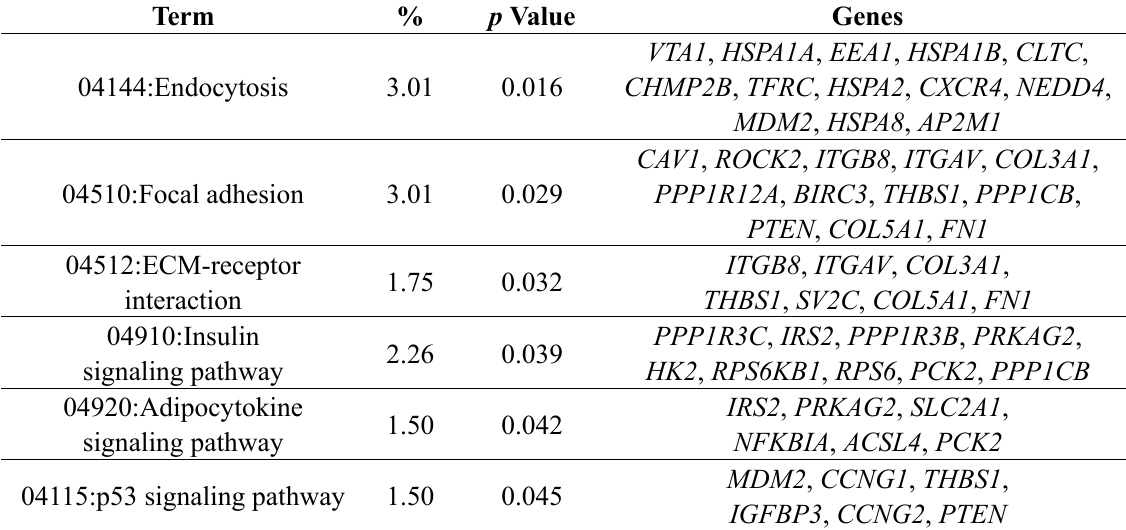
Table 2. Genes of KEGG pathway functional classification that were differentially expressed in 95D cells after c3orf1 siRNA treatment for 48 h (out of 537 genes, p < 0.05).